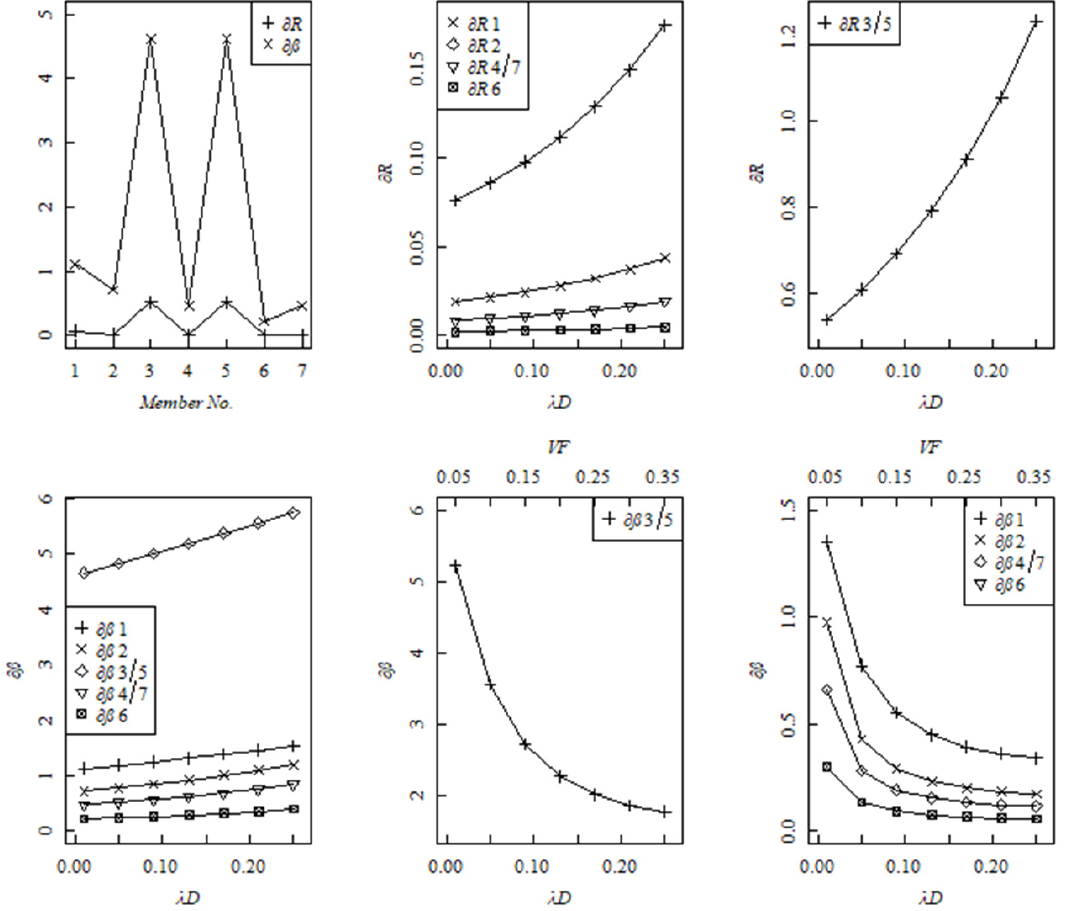
Figure 9. Different sensitivities of the structural robustness evaluation index ( ∂ R ) and structural reliability index ( ∂β ) of the truss beam subjected to damage effect ( λ D ) and variation factor ( VM ) ( Top left : ∂ R and ∂β vs. Member No ., top middle and right : ∂ R vs. λ D . Bottom left : ∂β vs. λ D , bottom middle and right : ∂β vs. λ D and VM ).